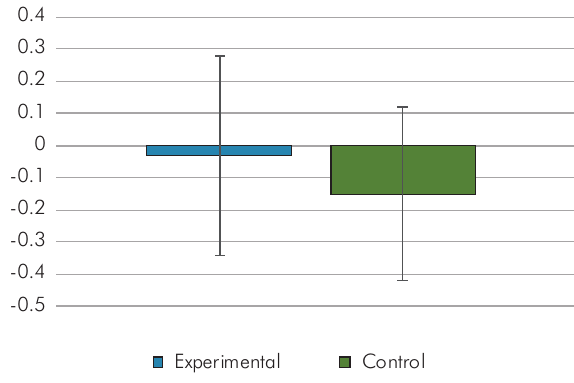
Figure 3. CGRP results for experimental and control teeth in the LLLT group; there was no significant difference between the experimental and control teeth in the LLLT group in terms of the total CGRP level change in the GCF before and after treatment (p >